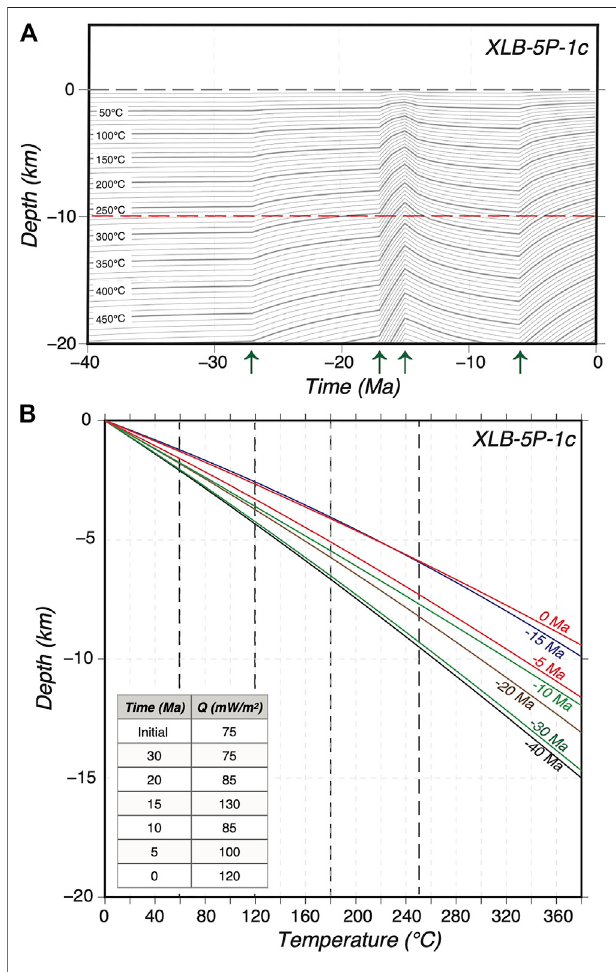
FIGURE 10 | Isotherm and geotherm histories for multi-stage exhumation history. (A) Isotherm evolution for exhumation history given by Model XLB-5P-1c. Times of changes in exhumation rates are indicated by arrows. Red dashed line indicates depth of 10 km. Depth to 300 ° C isotherm varies by approximately 4 km during this tectonic history. (B) Geothermsat selectedtimes duringthermalevolution.Table indicates surface heat fl ow for each geotherm